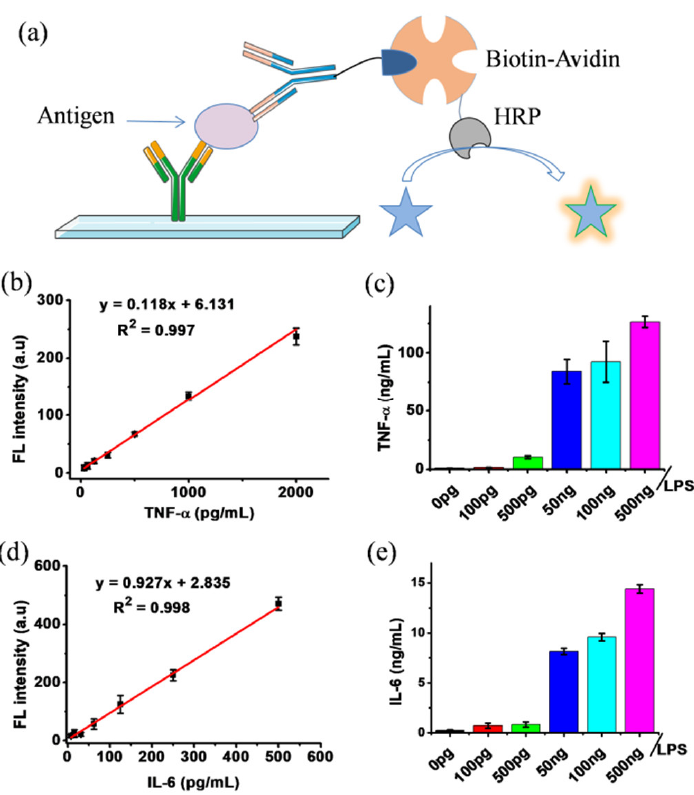
Figure 6. ( a ) Schematic figure illustrates the fluorescence detection procedure using DCFH-1 alternated ELISA kit. ( b ) The standard calibration curve obtained by using DCFH-1 as the fluorescence indicator in TNF-α detection. ( c ) TNF-α quantification result from the culture medium of inflammatory cell model. ( d ) The standard calibration curve obtained by using DCFH-1 as the fluorescence indicator in IL-6 detection. ( e ) IL-6 quantification result from the cultural medium of inflammatory cell model. LPS was used to stimulate the RAW264.7 cells to release more cytokines.